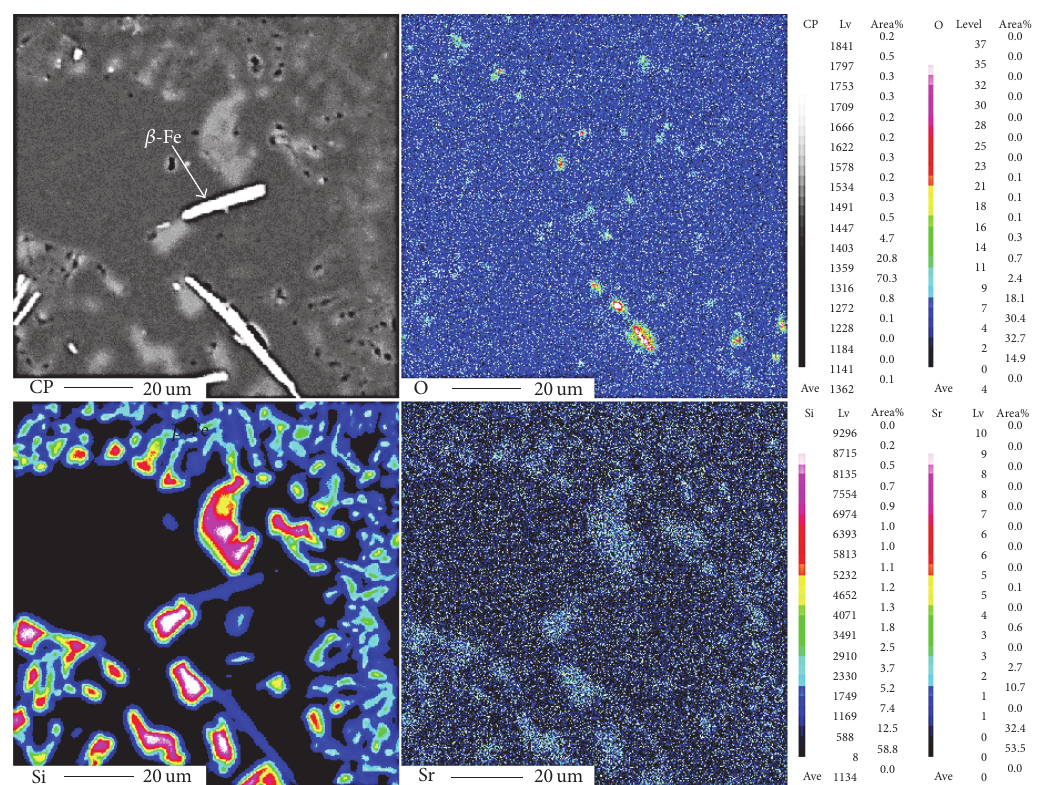
Figure 4: Distribution of Sr in the eutectic Si particles seen in the electron image in (a) of the A413 alloy sample shown in Figure 3(a).